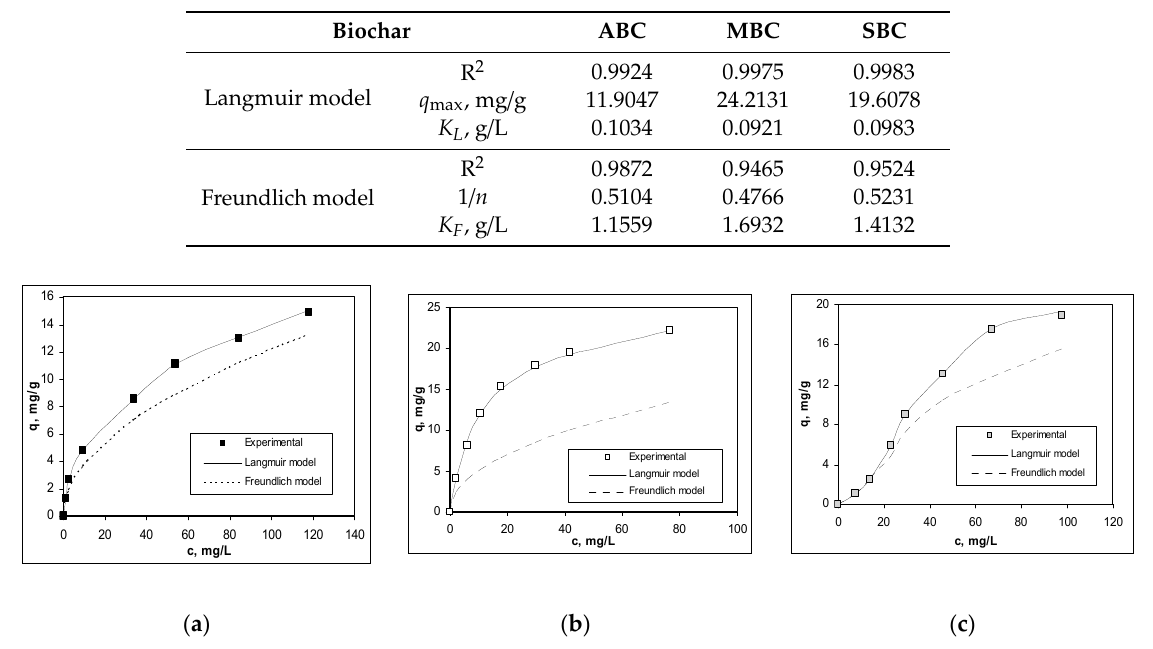
Table 2. Isotherm models parameters for the sorption of Co(II) ions on the three types of biochars.